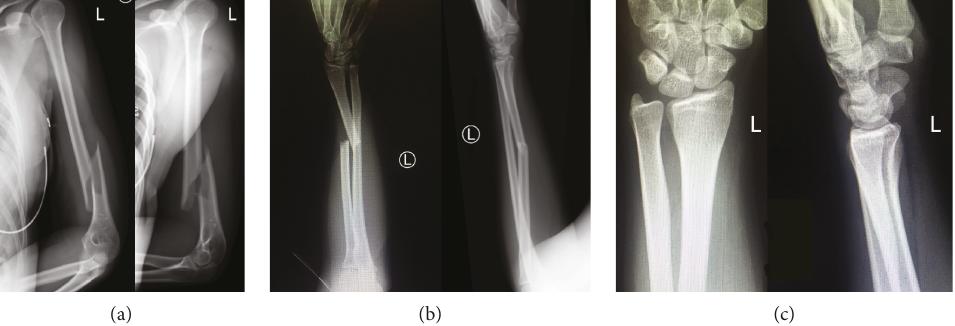
Figure 1: Anteroposterior (AP) and lateral radiographs of the humerus (a), forearm (b), and wrist (c) demonstrating a displaced left distal third humeral shaft fracture, a displaced left midshaft radius fracture with dislocation of the left distal radioulnar joint.